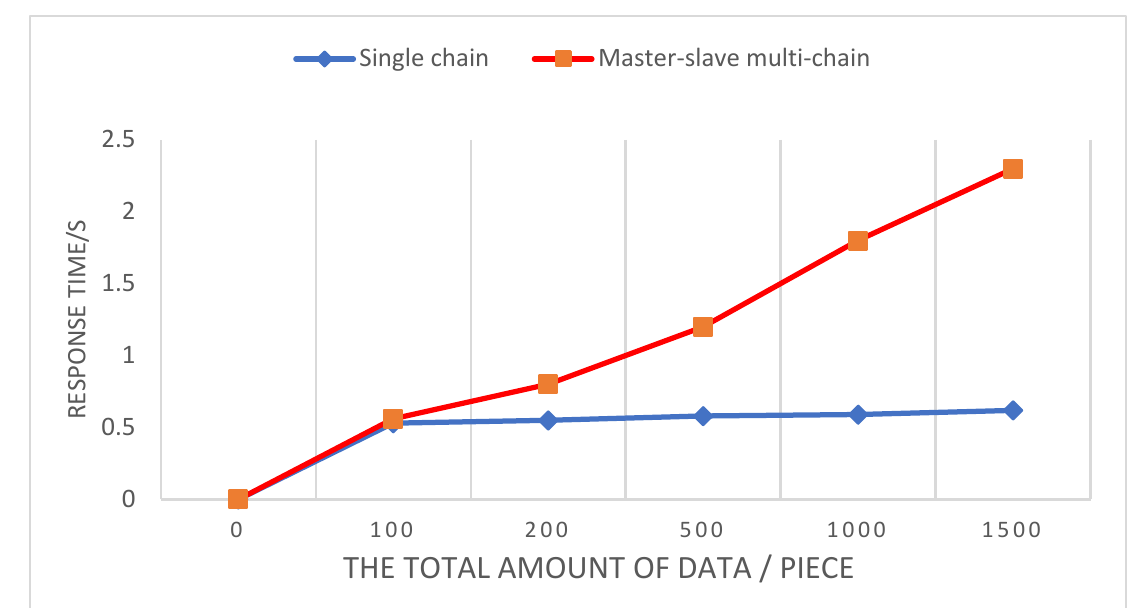
Figure 12. Comparison of query time between single chain and master–slave multi-chain.